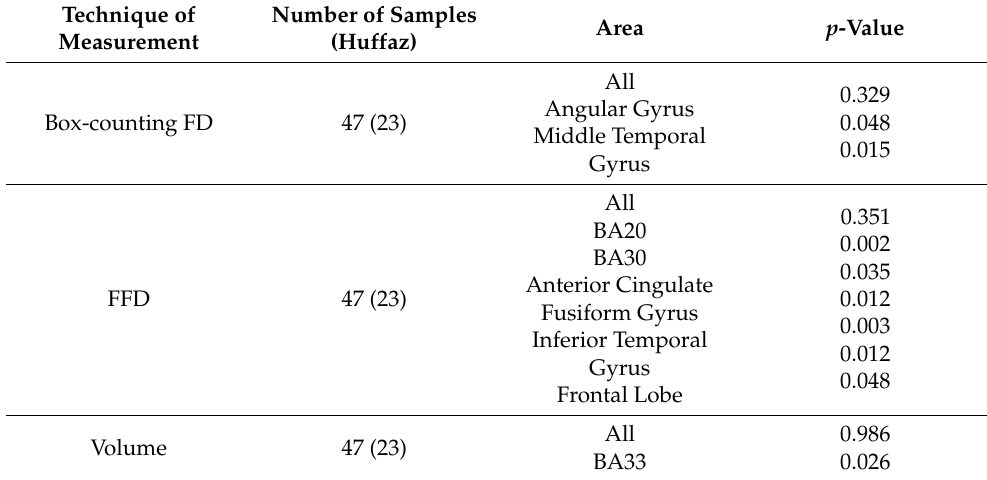
Table 1. Two-sample t -test of VOI-based analysis between huffaz and non-huffaz.